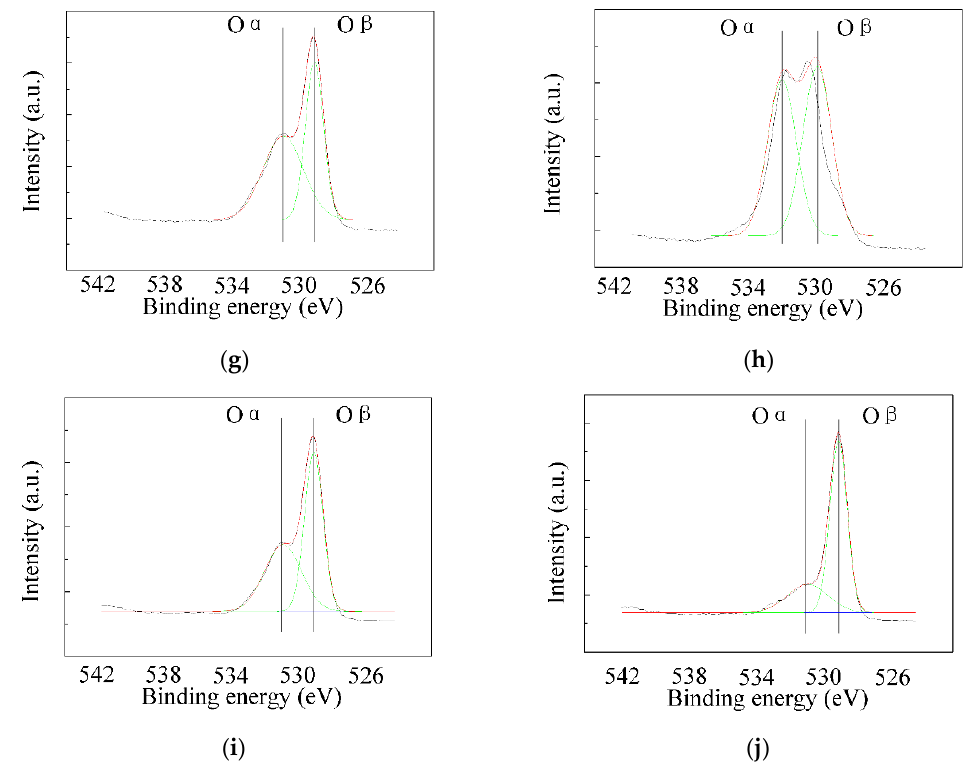
Figure 8. XPS results of O 1s.. ( a ) fresh Ce1.0Ti; ( b ) used Ce1.0Ti; ( c ) fresh Ce0.5Ti; ( d ) used Ce0.5Ti; ( e ) fresh Ce0.2Ti; ( f ) used Ce0.2Ti; ( g ) fresh Ce0.1Ti; ( h ) used Ce0.1Ti; ( i ) fresh pure TiO 2 ; ( j ) used pure TiO 2 . Table 5. The fraction of each type of oxygen.